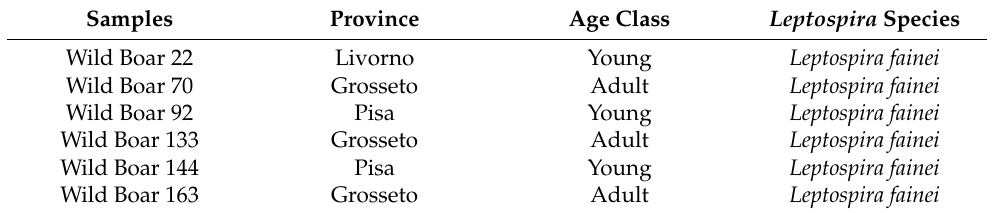
Table 1. Provinces and age classes of Leptospira fainei- positive wild boar sampled in the Tuscany region. Samples